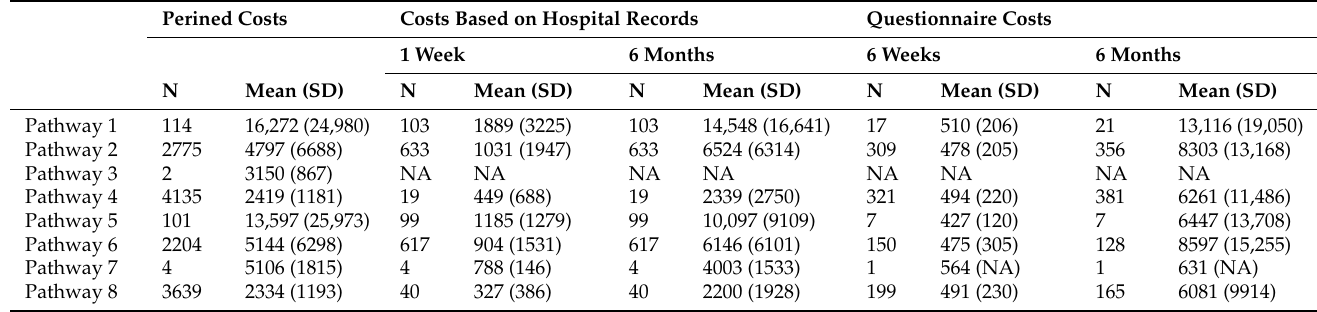
Table 4. Costs per outcome strategy based on Perined data, hospital records and survey